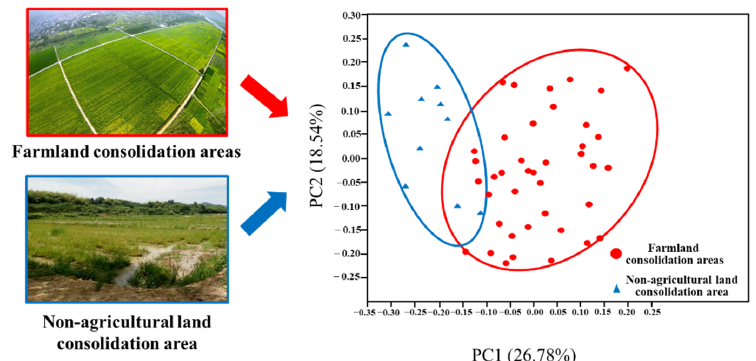
Figure 3. The PCoA map of fungal communities with OTU levels of samples between different